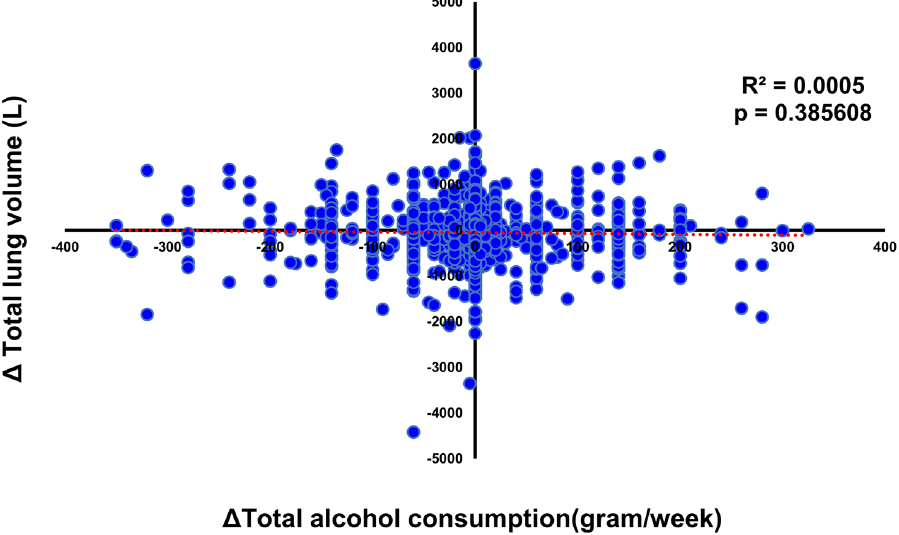
Figure 5. Changes in alcohol consumption did not affect time-related total lung volume decline. Time course analysis of the effect of changes in alcohol intake on time-related deterioration of total lung volume calculated from CT scans. The X axis represents the change in the alcohol intake and the Y axis represents changes in total lung volume from the same persons in 2013 and 2018. The line represents an approximate straight